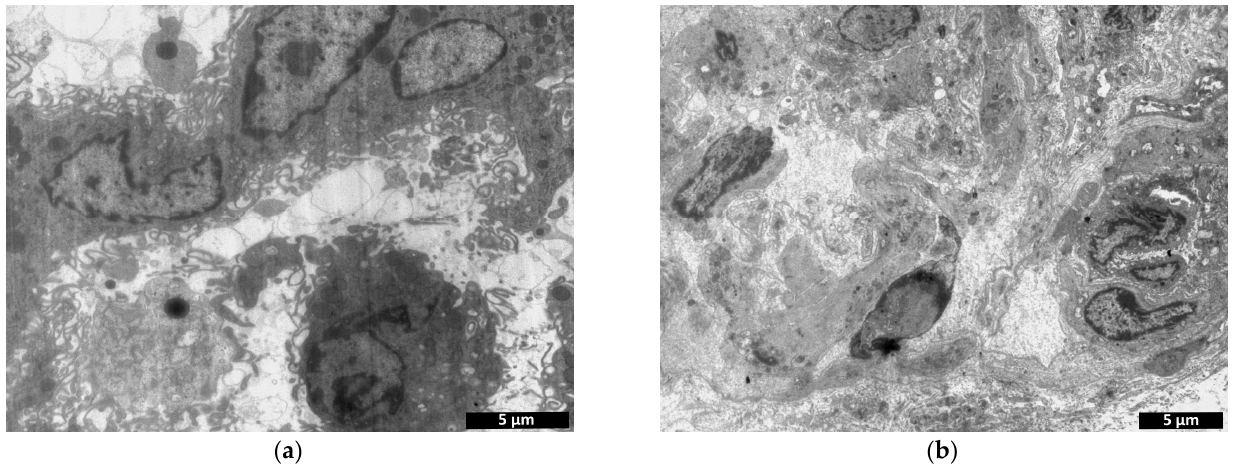
Figure 14. Comparison of experimental cells of fibroblastic origin—cell-containing scaffold ( a ) and control—cell-containing collagen matrix ( b ): transmission microscopy, day 7.